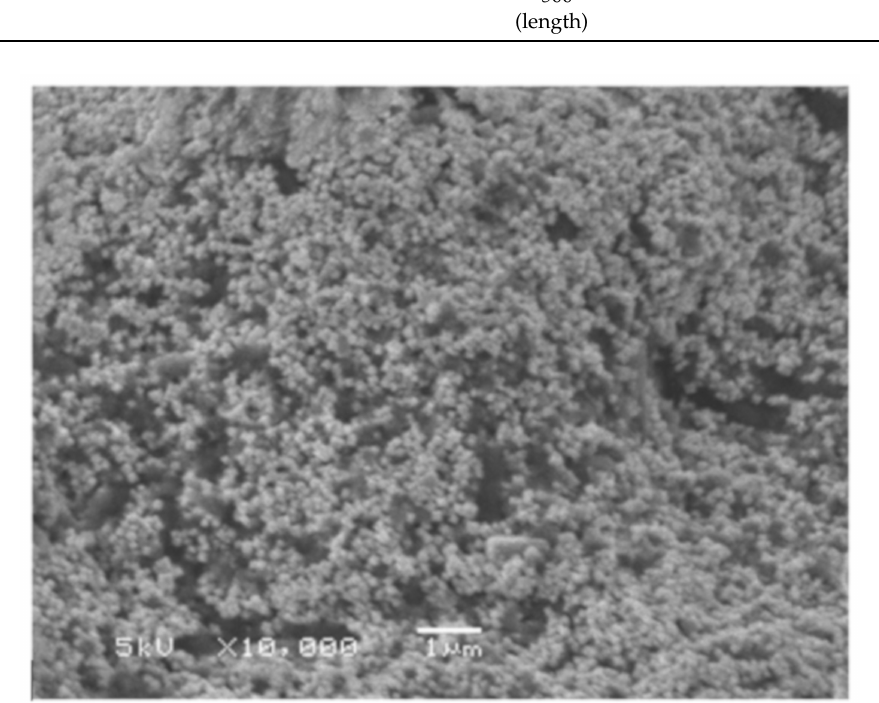
Figure 2. Scanning electron microscope (SEM) images of Ag-NP obtained using aqueous peel extract of Punica granatum